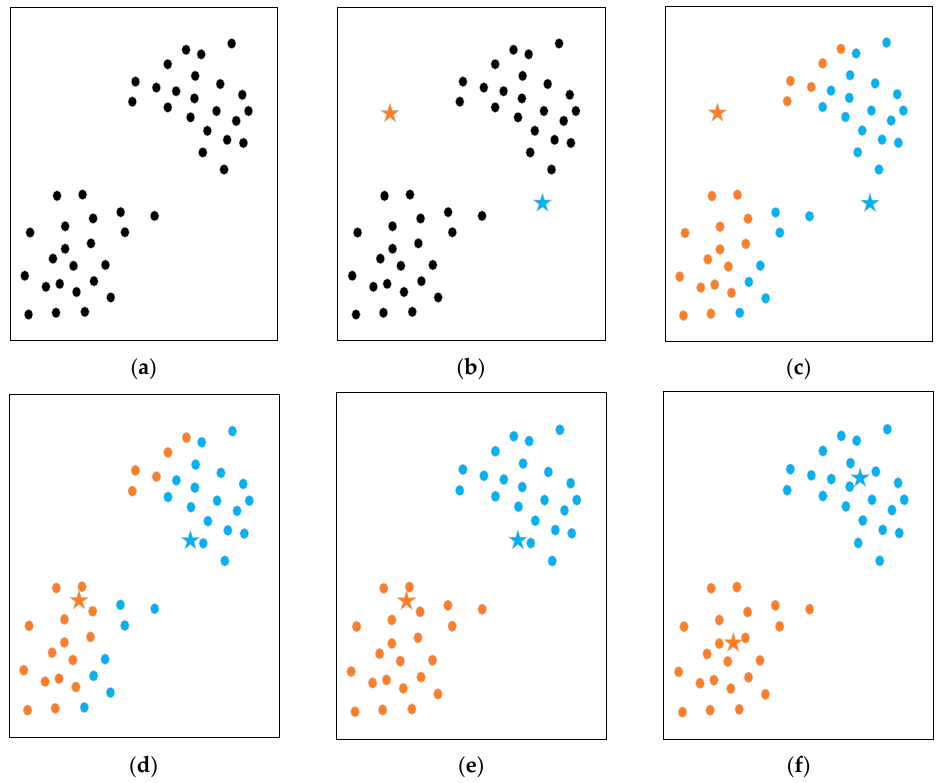
Figure 4. The K-means algorithm: ( a ) raw point cloud; ( b ) the star symbol represents the centers of random initial clusters and points marked with the same color are represented as being divided into the same cluster; ( c – f ) the iterative running process of the K-means algorithm. In each iteration, the point is assigned to the center of the nearest cluster.